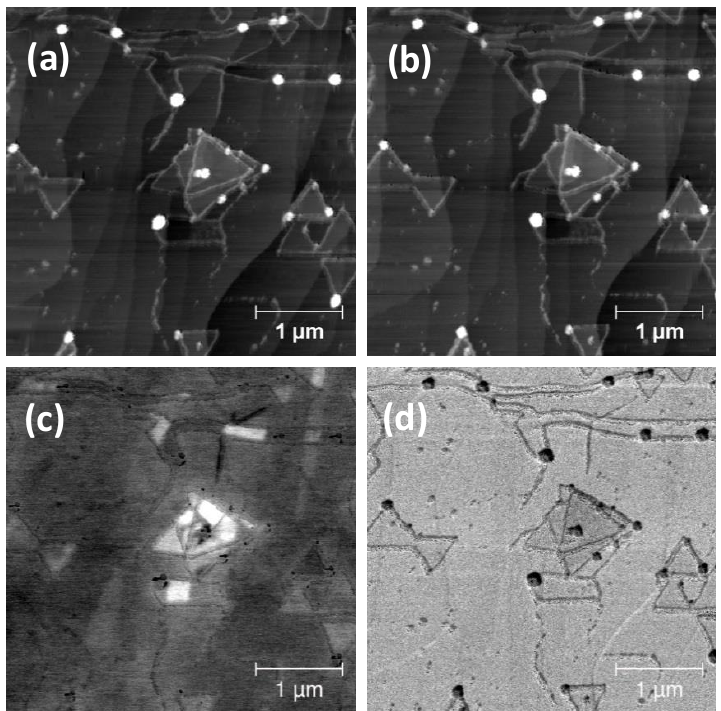
Figure 5. KPFM and DFM data obtained on the same sample of Figure 4, in the same region: ( a , b ) morphology and the corresponding ( c ) first harmonic channel (KPFM) and ( d ) second harmonic channel (DFM). The electrostatic maps have been obtained applying 2 V to the tip, at a frequency of 489 kHz ( c ) and 244.5 kHz ( d ).